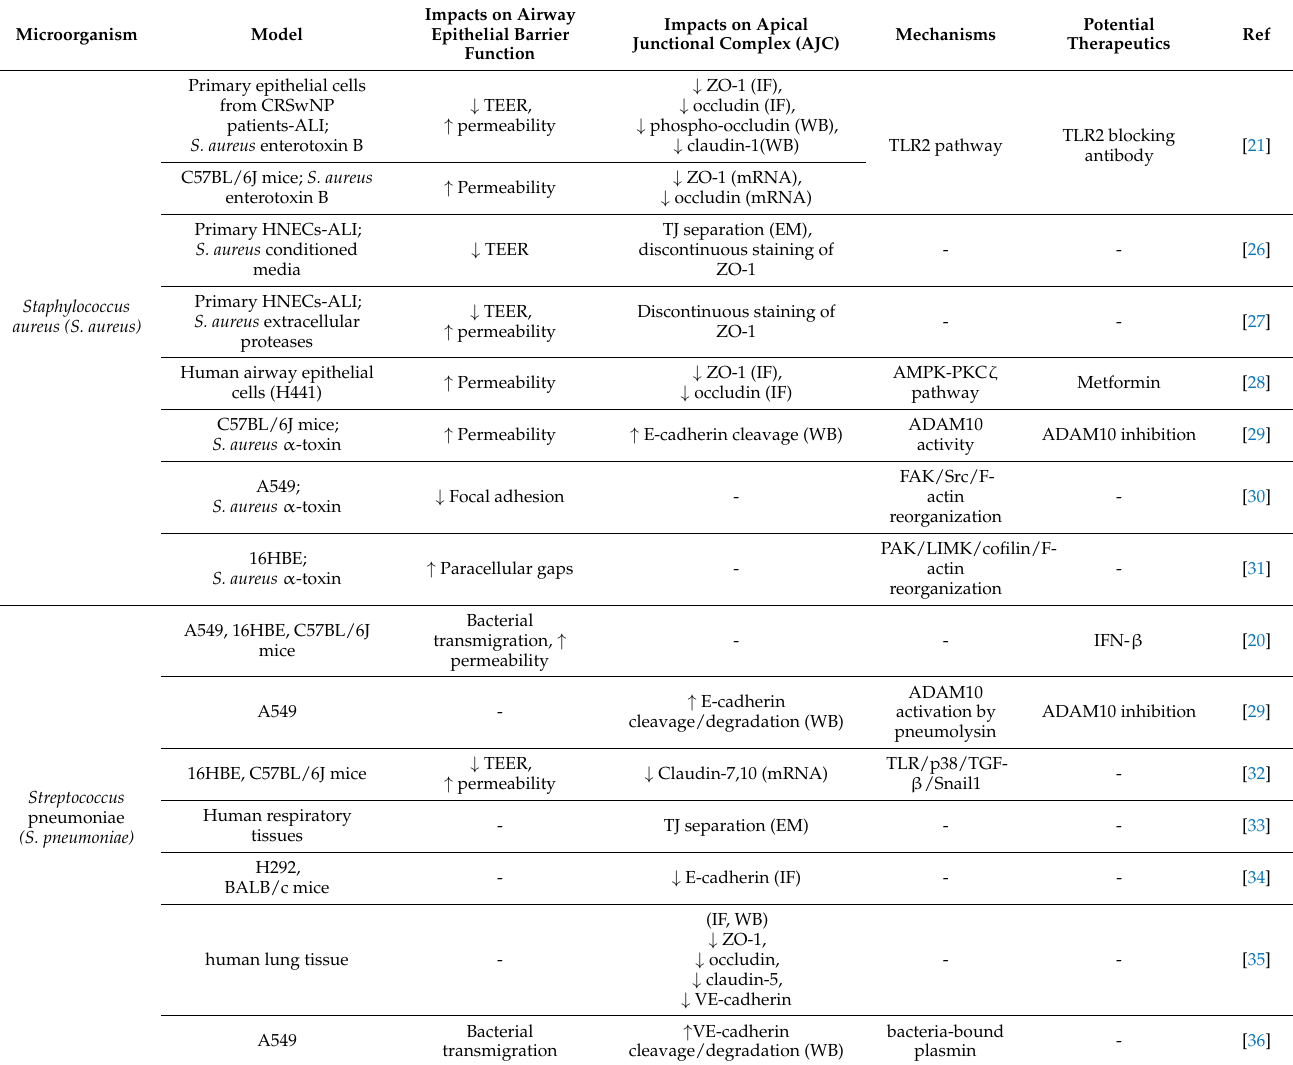
Table 1. Bacterial disruption of airway epithelial barrier and